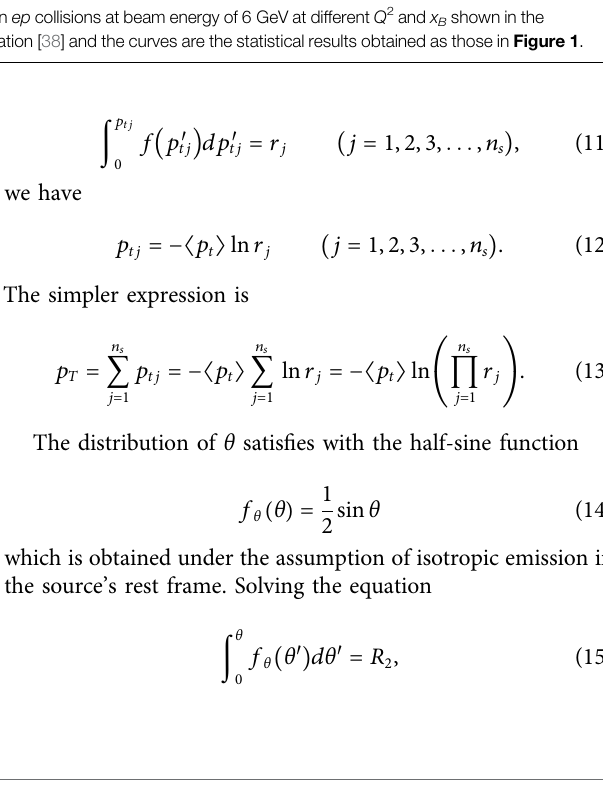
Frontiers in Physics |